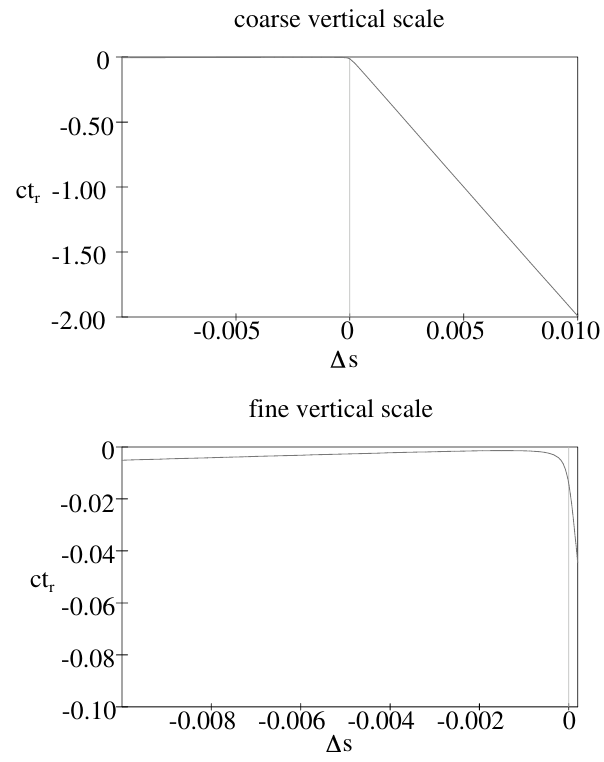
(cid:4) s with t s